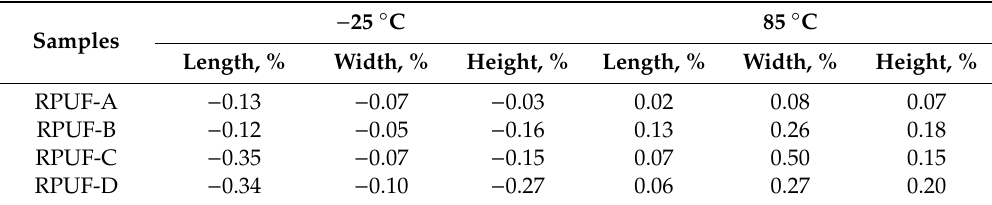
Table 3. Dimensional stability of RPUFs at different temperature.